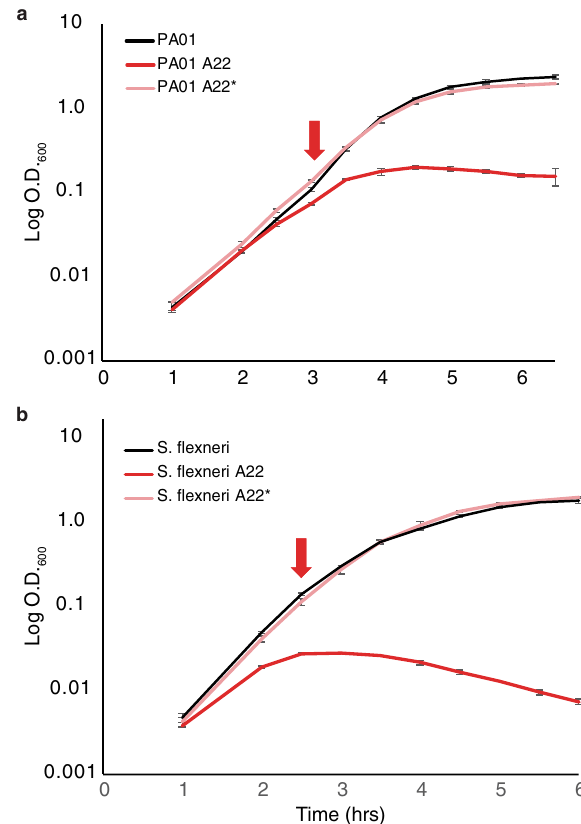
Fig. 6 Other Gram-negative rod species display DDGR. a Growth curve of Pseudomonas aeruginosa PA01 grown at 37 °C in LB, LB A22 (20 μ g/ml), and LB with A22 added at the indicated time point where OD 600 ~0.1 (*). b Growth curve of Shigella fl exneri (ATCC 12022) grown at 37 °C in LB, LB A22 (10 μ g/ml), and LB with A22 added at the indicated time point where OD 600 ~0.1 (*). Error bars are standard deviation from three biological